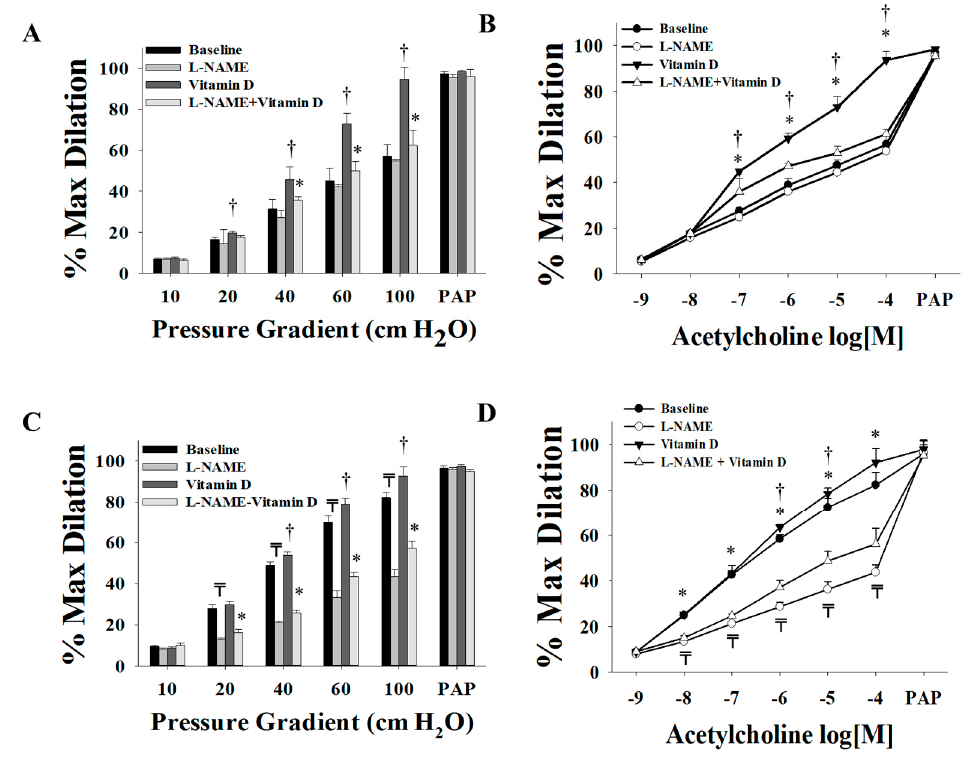
Figure 3. Effect of endothelial nitric oxide synthase (eNOS) inhibition via L-NAME on FID and AchID in adipose tissue resistance arterioles collected on the day of surgery ( n = 15 subjects). FID measurements corresponding to intraluminal pressure gradients of 10 – 100 cm H 2 O in VAT arterioles ( A ) and SAT arterioles ( C ) with and without vitamin D incubation. AchID measurements corresponding to increasing Ach concentrations (10 − 9 to 10 − 4 M) in VAT arterioles ( B ) and SAT arterioles ( D ) with and without vitamin-D incubation. All measurements are presented as means ± standard error (SE); ₸ p < 0.05 comparing L-NAME with baseline, † p < 0.05 comparing vitamin D with baseline, and * p < 0.05 comparing L-NAME + vitamin D with vitamin D alone.